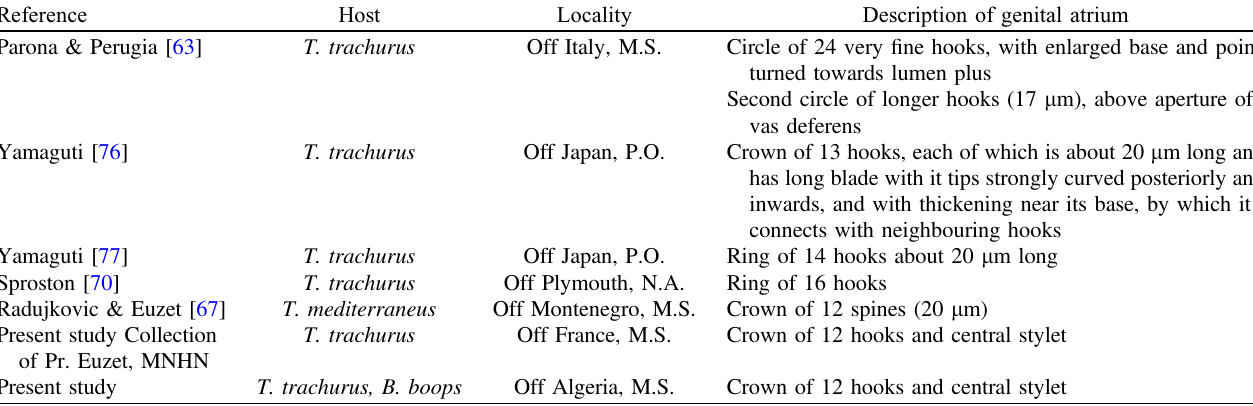
Table 4. Descriptions of the genital atrium of Pseudaxine trachuri